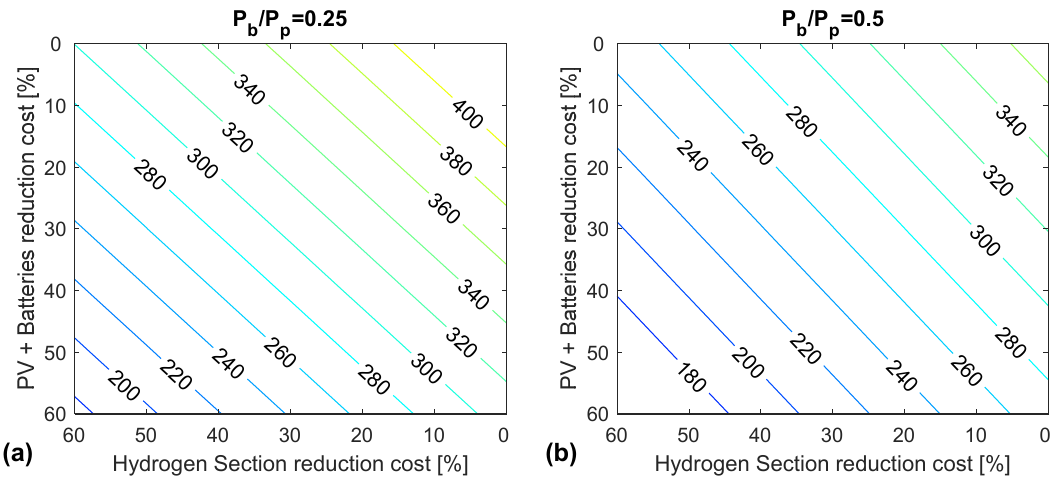
Figure 14. Sensitive analysis on LCOE (expressed in (EUR / MWh)) for di ff erent hydrogen section (hydrogen generator + storage + fuel cell) and PV section (PV + batteries) costs considering a k PV of 1.2 and k HG equal to 0.6 for ( a ) P b /P p = 0.25 and ( b ) P b /P p =